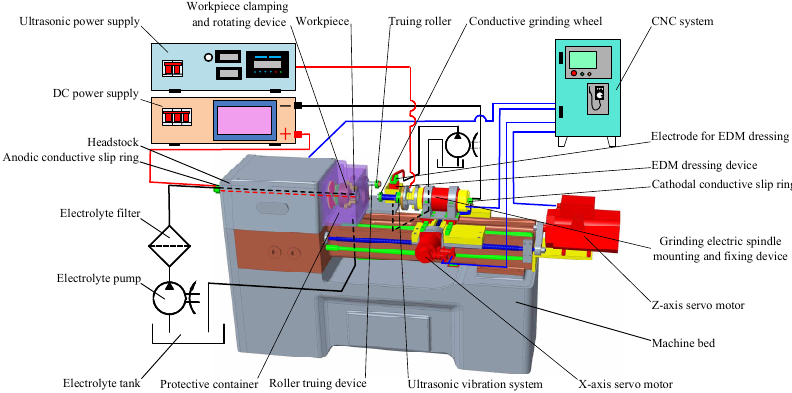
Figure 3. Overall structure of the special machine tool for ICUAECG.